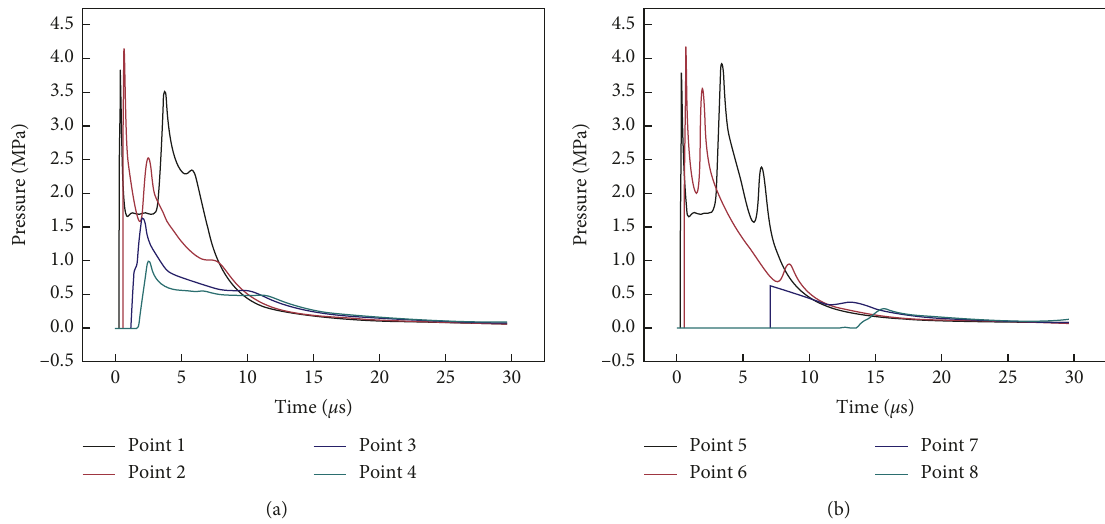
Figure 13: Blast wave pressure versus time in two directions in free field. (a) Cutting seam direction. (b) Vertical cutting seam direction.